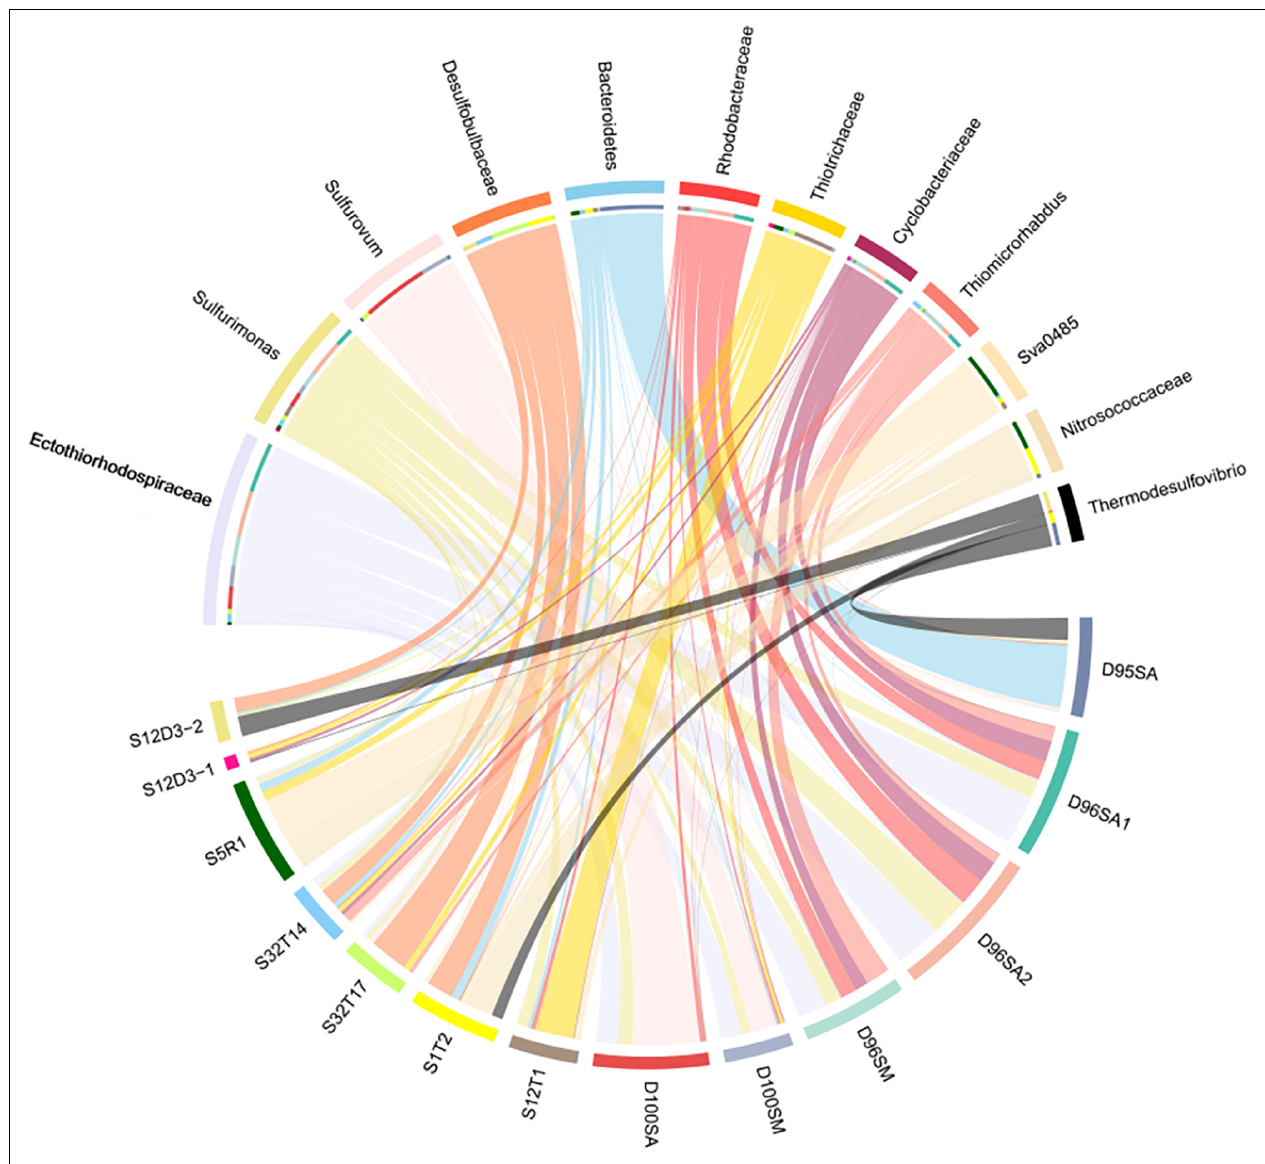
FIGURE 3 | The chord diagram chart showing the distribution of dominant genera. The analysis was performed using the microbial communities at the genus level. D100SA, D96SA1, D96SA2, and D95SA refer to 16S rRNA gene amplicons; D100SM and D96SM are 16S miTags obtained from the metagenomes. The other samples are referred in Supplementary Table 2